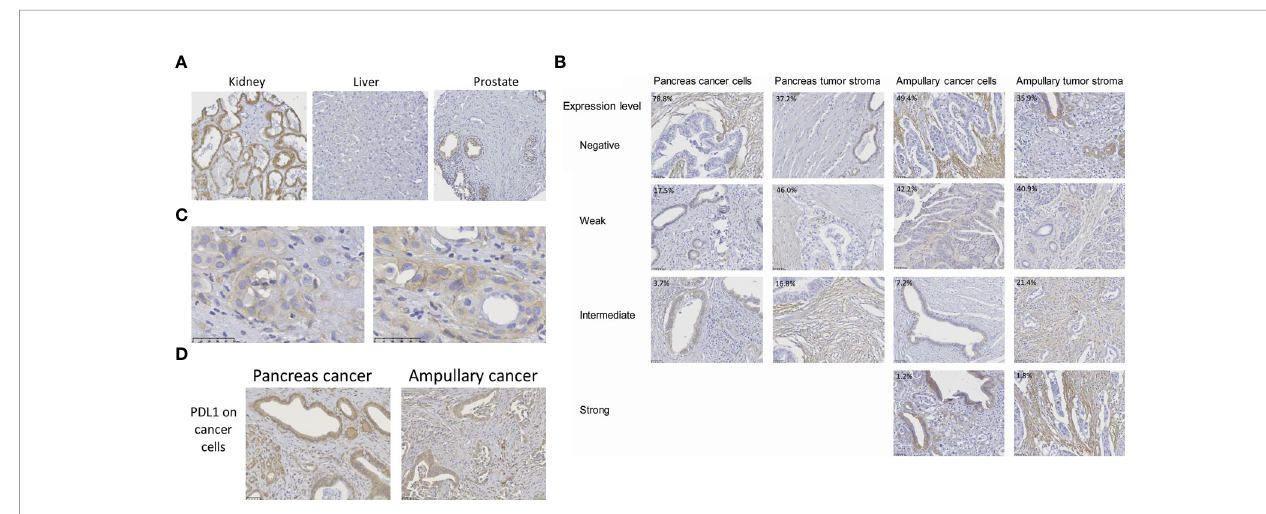
FIGURE 1 | B7-H3 expression in pancreas cancer, ampullary cancer and healthy tissues. (A) B7-H3 expression in human kidney, prostate and liver, as determined by immunohistochemistry using the SP206 monoclonal antibody. For kidney, the tissue with the highest expression in our TMA is shown. (B) B7-H3 expression levels in cancer cells and in tumor stroma were scored separately, as negative, weak, intermediate, or strong. B7-H3 expression in cancer cells was predominantly visible in the cytoplasm, but in some cases (e.g. in the pancreatic cancer with intermediate level of B7-H3 expression in cancer cells) additional membrane expression was observed. In stromal cells, B7-H3 expression was more often localized at the cell membrane. There were no pancreatic tumors with high B7-H3 expression in cancer cells or in stroma. Percentages depicted in the pictures are percentages of tumors with the level of expression shown in the respective pictures. (C) Two additional examples of distinctive B7-H3 membrane expression in cancer cells of pancreatic cancer patients. (D) For comparison, examples of PD-L1 expression in cancer cells of both cancer types is